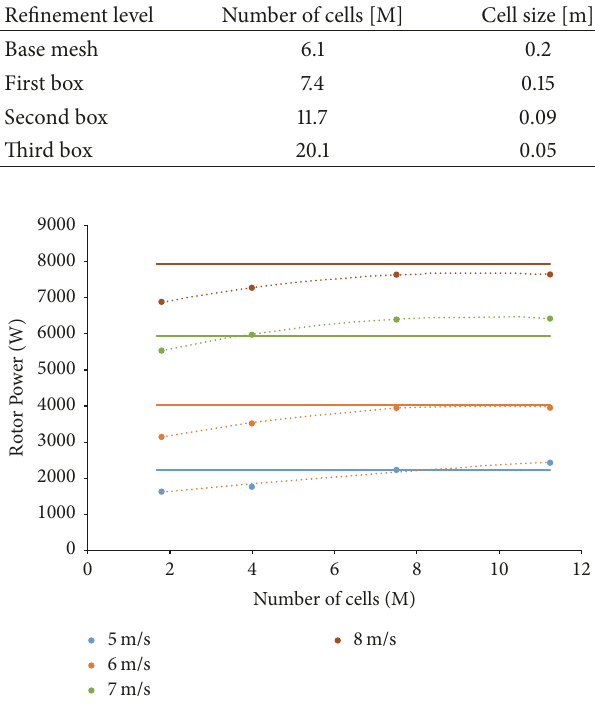
Figure 2: Grid convergence for different levels of refined grids and wind